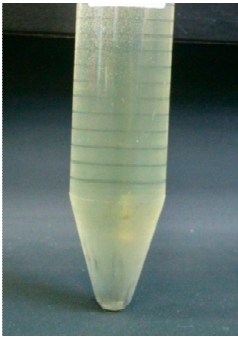
Figure 7. DTX-loaded nanomicelle solution.